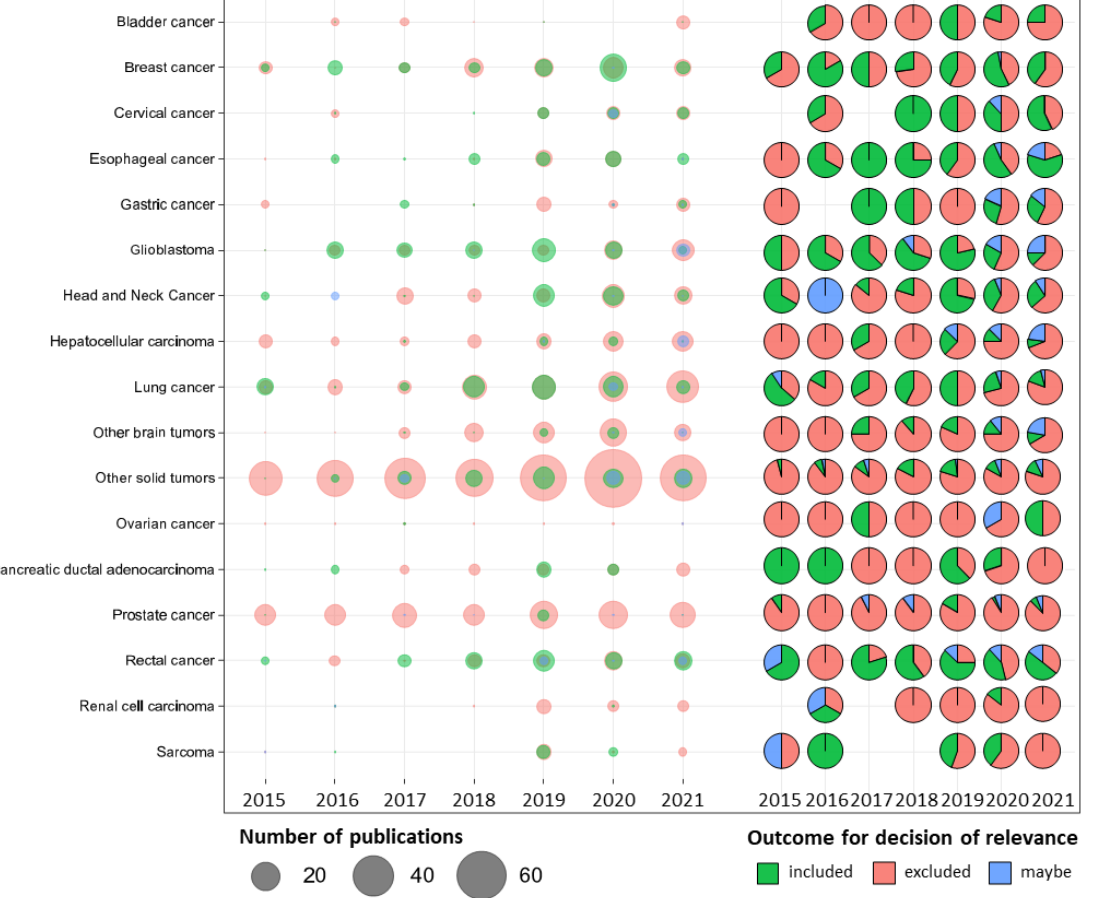
Figure 2. The outcome of the decision by year of publication. The bubble chart summarizes the relationships between tumor types, year of publication, number of publications and outcome of the relevance of assessment at abstract screening. The size of the dots represents the number of publications and the colors of the outcome of the decision after assessing the relevance of the publications’ abstracts. The scatter pie chart summarizes the proportion of papers in each relevance category.